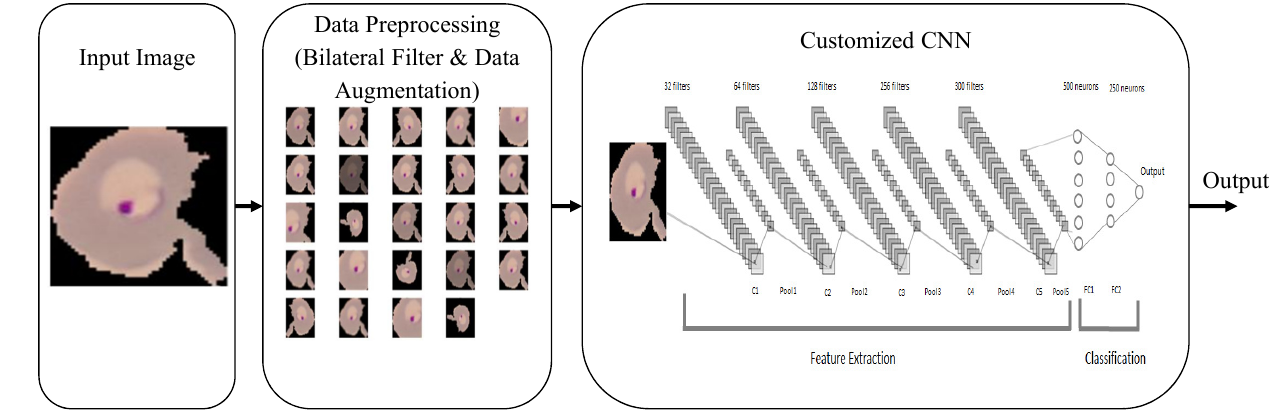
Figure 2. Block diagram of the proposed malaria